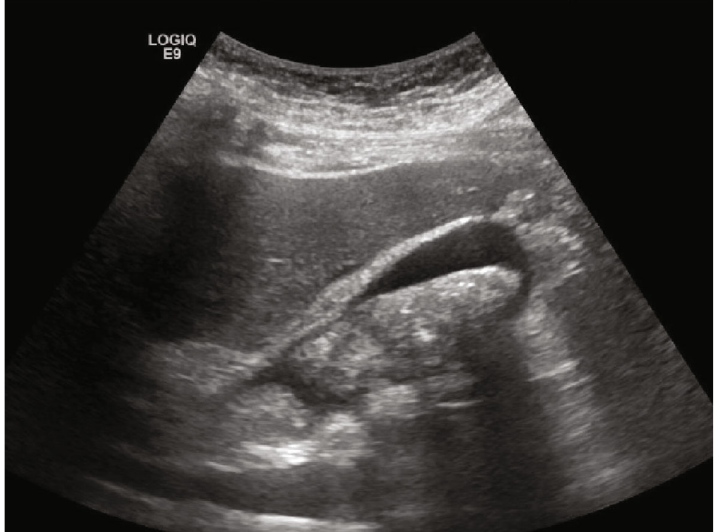
Figure 1: Abdominal ultrasound shows sludge in the gallbladder, gallbladder wall thickening, and pericolecystic fl